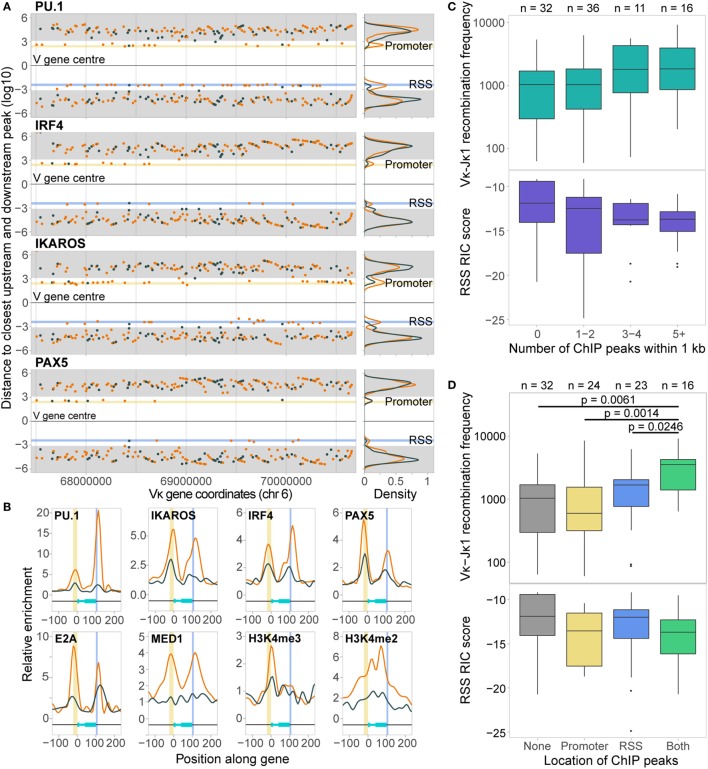
Chromatin features associate with both the promoters and recombination signal sequences (RSSs) of active Vκ genes. (A) Scatter plots and density plots showing the log10-transformed distances of the closest ChIP-seq peaks both up- (+) and downstream (−) from the centre of active (orange) and inactive (dark grey) Vκ genes. Yellow (promoter) and blue (RSS) shading indicates the range of distances within which 80% of the start and end sites of Vκ genes, respectively, are located. Grey shading indicates a distance of >1 kb from the Vκ gene, based on the median Vκ gene length (525 bp). (B) Average enrichment, relative to background, of chromatin features across all active (orange) and inactive (dark grey) Vκ genes. Genes have been scaled such that 0 and 100 represent the start and end of the gene, respectively. Yellow and blue shading indicates the location of the promoters and RSSs, respectively. (C,D) Median recombination frequencies and RSS Information Content (RIC) scores of active genes, excluding 10 genes that had <70% mappability. Genes are categorised based on the number of ChIP-seq peaks within 1 kb of the gene (C), or the localisation of those peaks upstream (promoter) or downstream (RSS) of the gene centre (D). p-values for Vκ-Jκ1 recombination frequency are fdr adjusted, based on a two-sided Wilcoxon rank sum test. n values indicate the number of genes in each category.